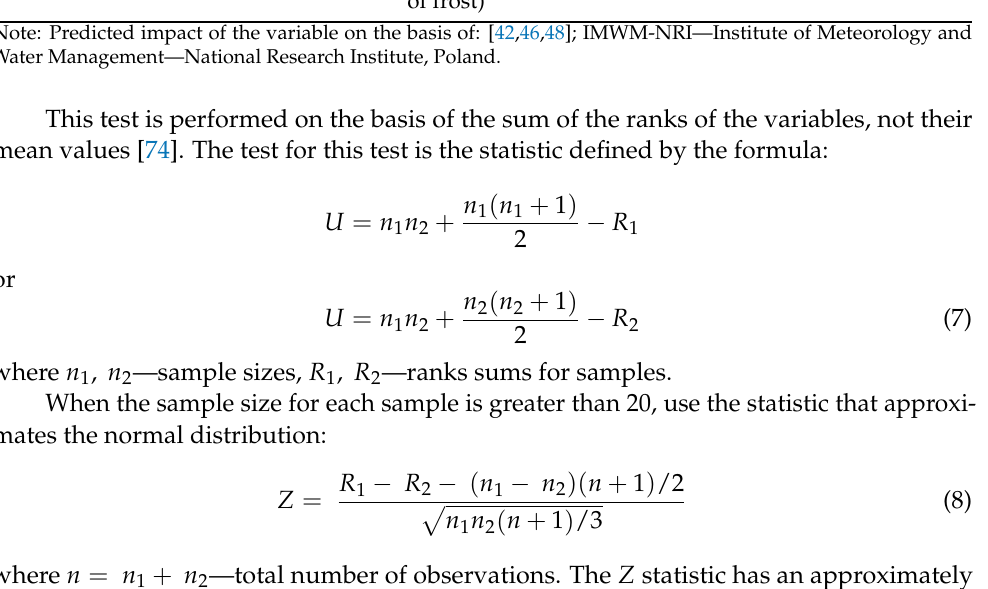
Table 1. Set of variables adopted to determine the factors determining diversification in small farms. Variables Category X